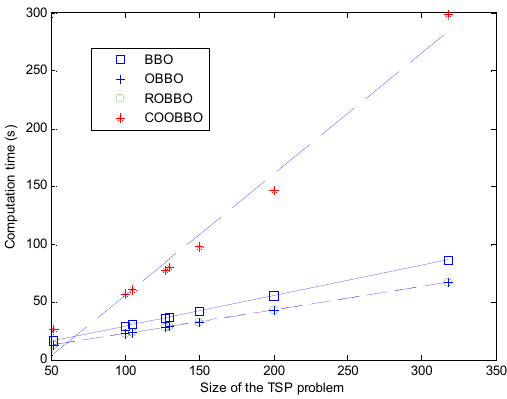
Figure 9. Comparison of computation time of BBO, OBBO, ROBBO and COOBBO algorithms.